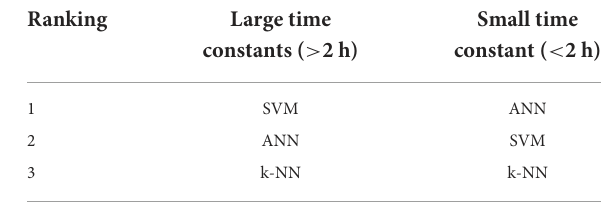
TABLE 7 Ranking of prediction models based on